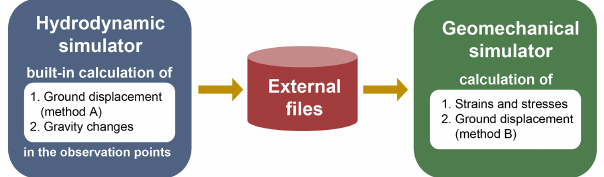
Figure 2. Diagram showing the software options for modelling gravity changes and ground displacement. The interface between the simulators is organised through external files.